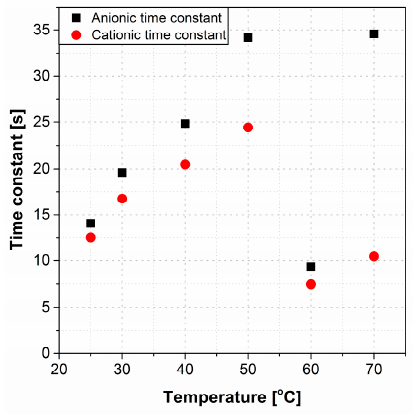
Figure 7. The time constant of cationic and anionic curvatures at different temperatures.